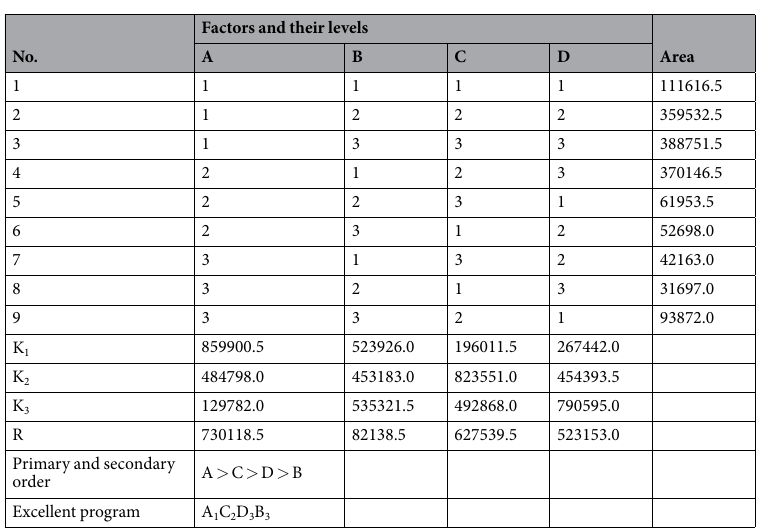
Table 2. Results and analysis of L 9 (3) 4 orthogonal